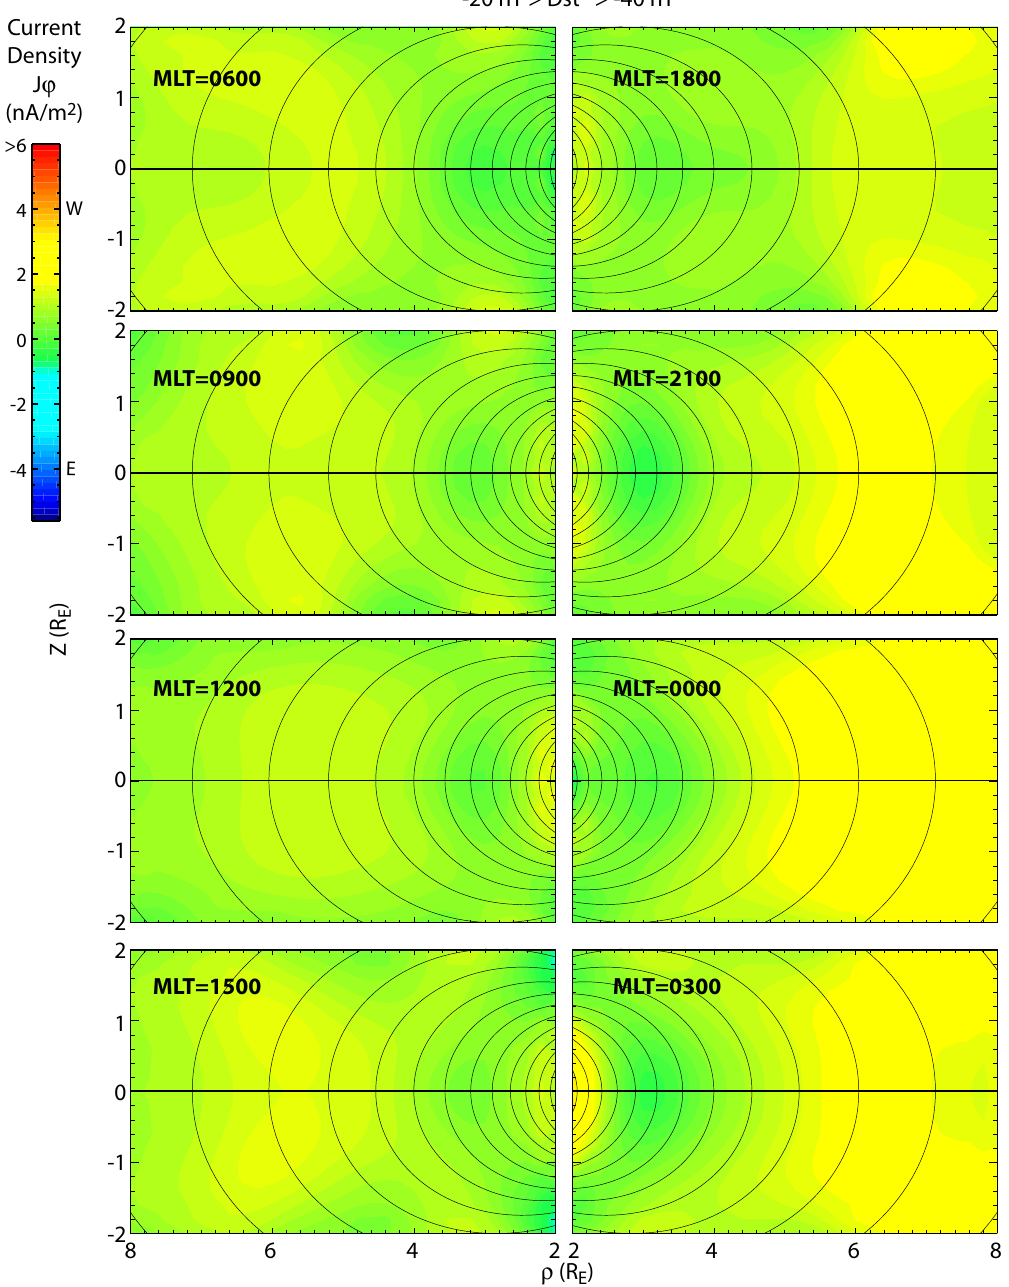
Fig. 6a. Azimuthal component of the current density (or the ring current density) with superimposed dipole field lines for each of the four D st * levels: (a) − 20nT >D st * > −